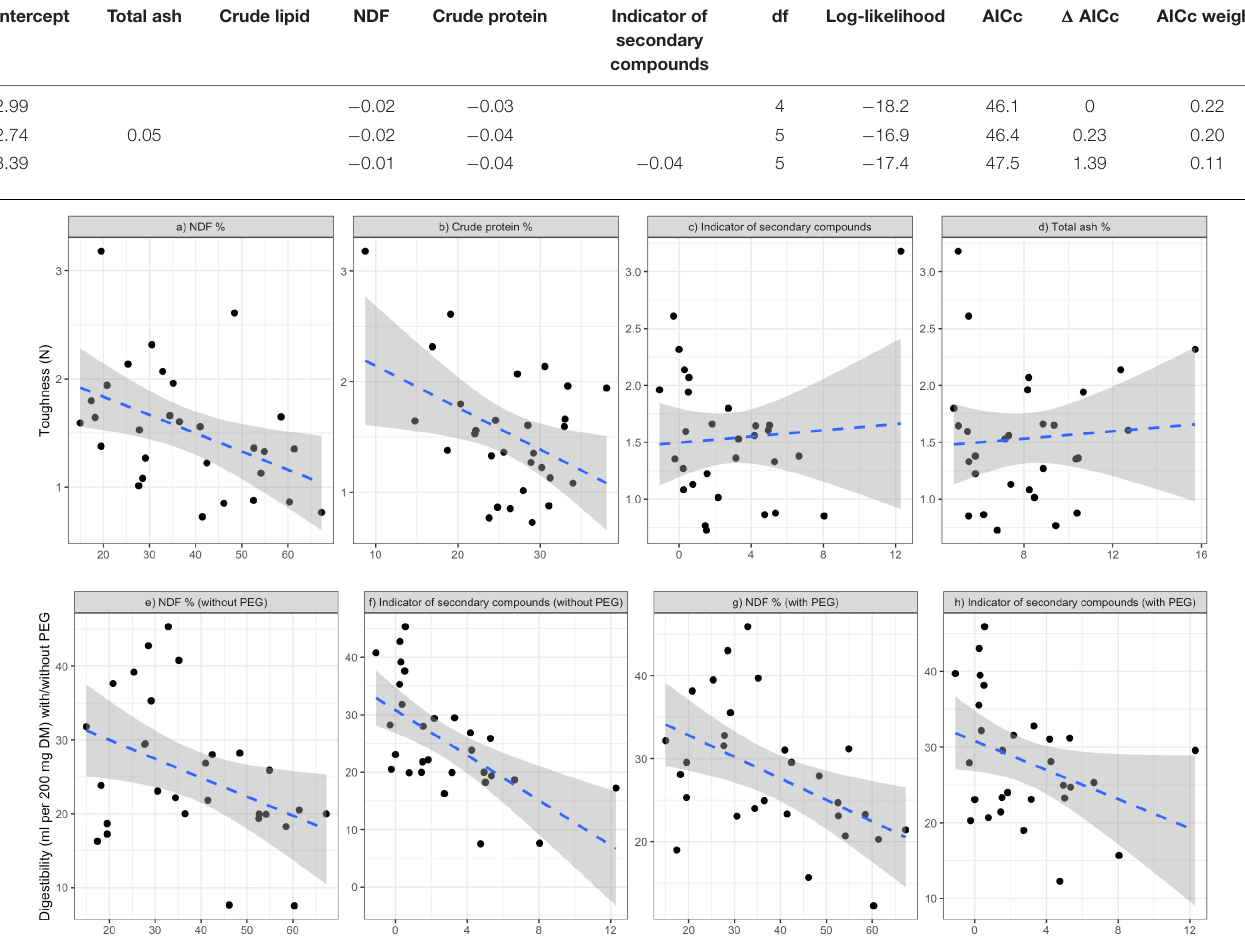
FIGURE 1 | Relationships of leaf toughness (a–d) and in vitro digestibility (e–h) with chemical properties, respectively, based on the model selection Tables 1 , 2 . Blue dotted lines and shaded areas represent the linear regressions estimated by the “lm” method in R for the observed samples and their 95% confidence interval ranges,